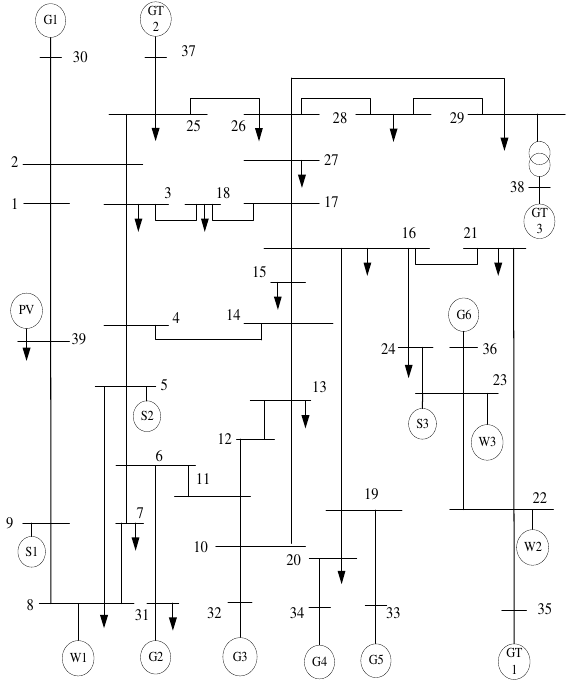
Figure 1. Modified IEEE 39 bus system.